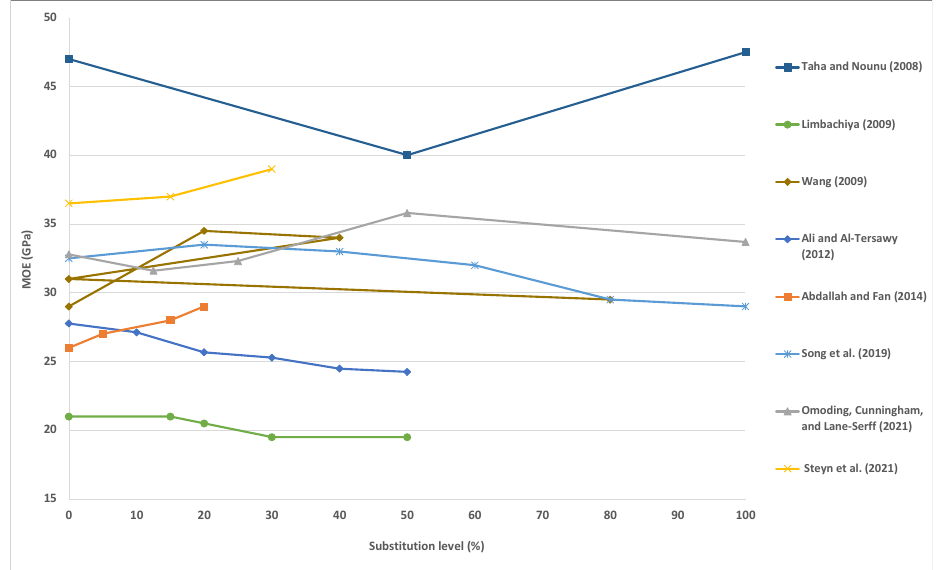
Figure 3. Modulus of elasticity of concrete with various contents of the waste glass. Adapted from